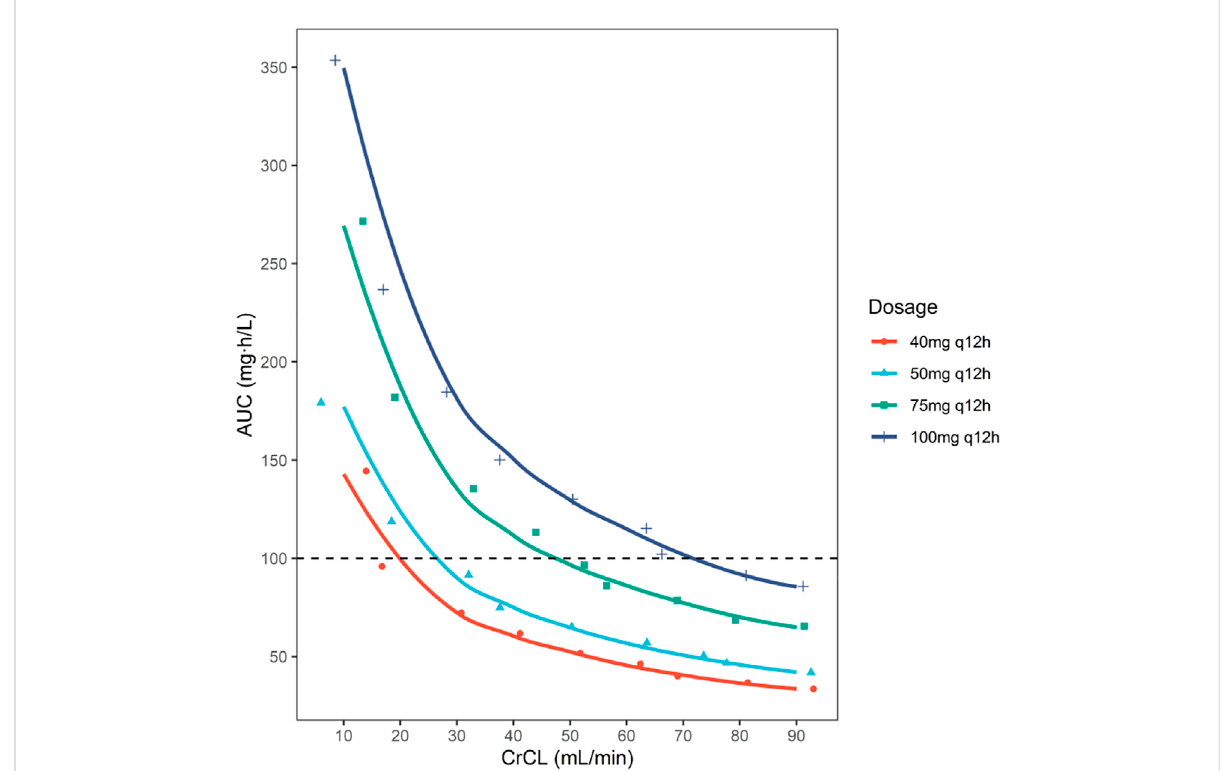
FIGURE 5 ThesimulatedAUC ss,24h ofpolymyxin Bon40,50,75,and100 mgq12hregimensinlungtransplantpatientswithdifferentcreatinineclearance. Safety target was set as AUC ss,24h < 100 mg